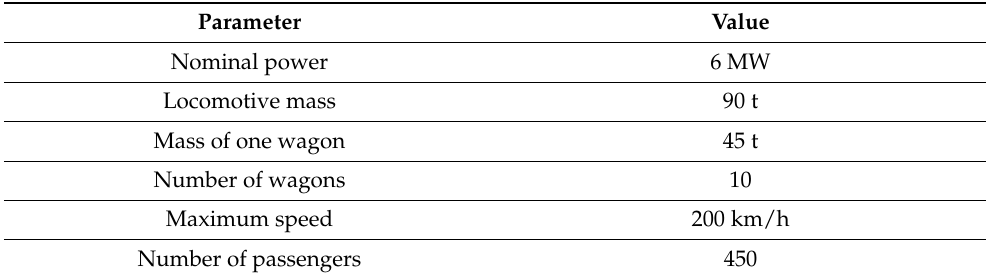
Table 5. Assumed parameters of a passenger train PAS with a BoBo